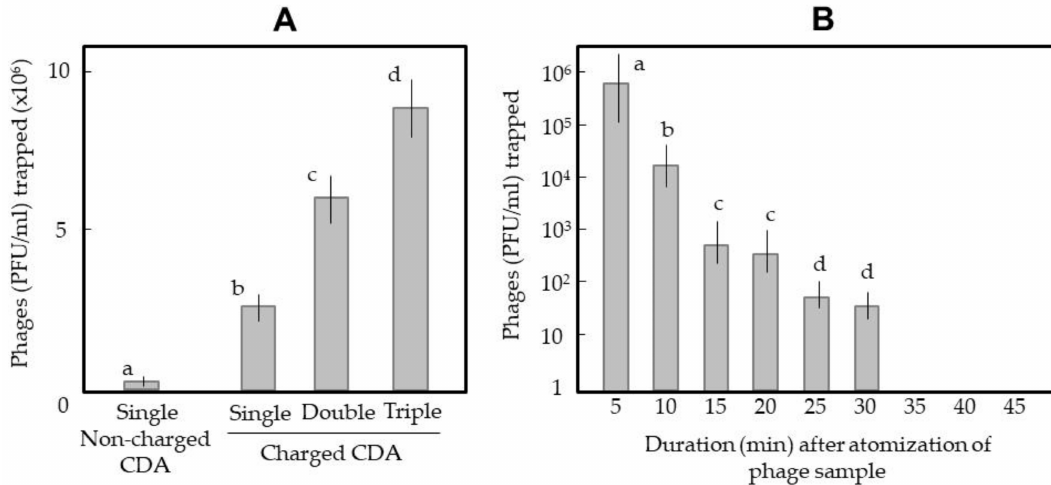
Figure 7. ( A ) Trapping of phages atomised into air with a single CDA and with double- and triple-linked CDAs. A non-charged CDA was used singly as a negative control. The trapping time was 30 min. ( B ) Time relationship of trapping of phages atomised into the air with the triple-linked CDAs. In both experiments, 5 mL of phage solution (10 8 PFU/mL) was atomised for 5 min and collected for 30 min with − 10 kV-charged CDA(s). Phage-trapping efficiency was determined by the double-layered agar method. The means and standard deviations in ( B ) were calculated from five repetitions of the experiments. The letters (a–d) in each graph indicate significant differences ( p < 0.05) according to Tukey’s